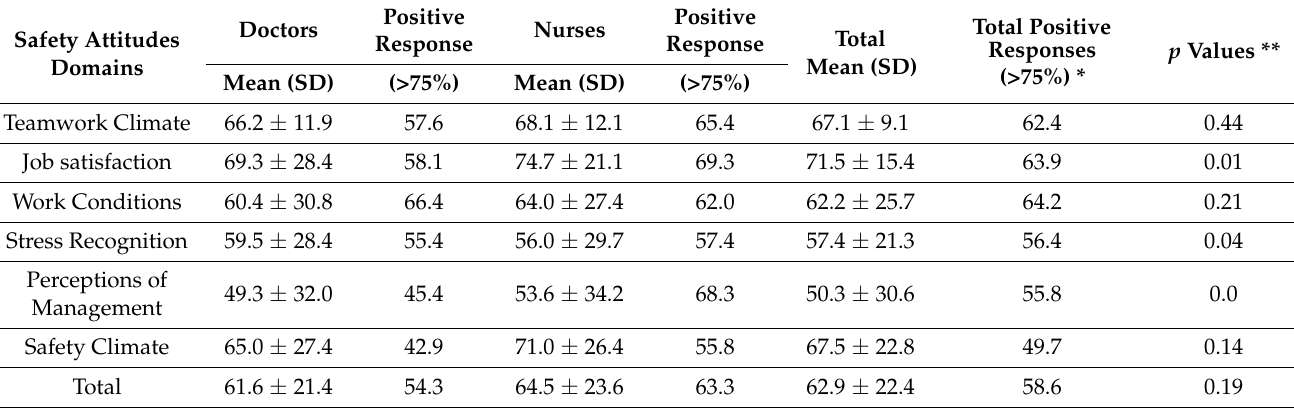
Table 3. Attitudes of participants related to patient safety.